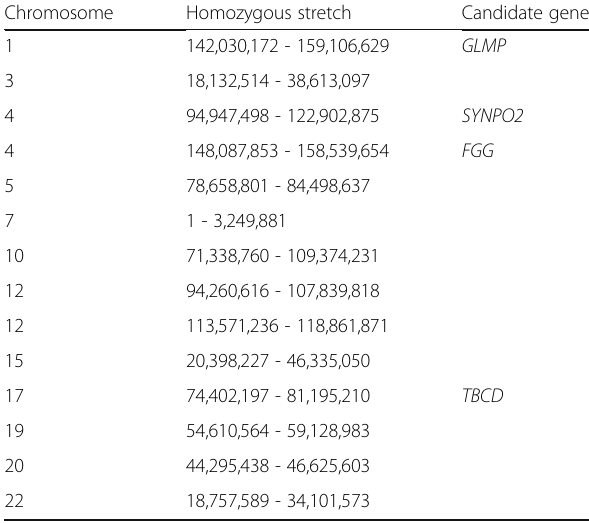
Table 1 Homozygous areas identified in the proband (Fig. 1a-II.4) and the position of candidate